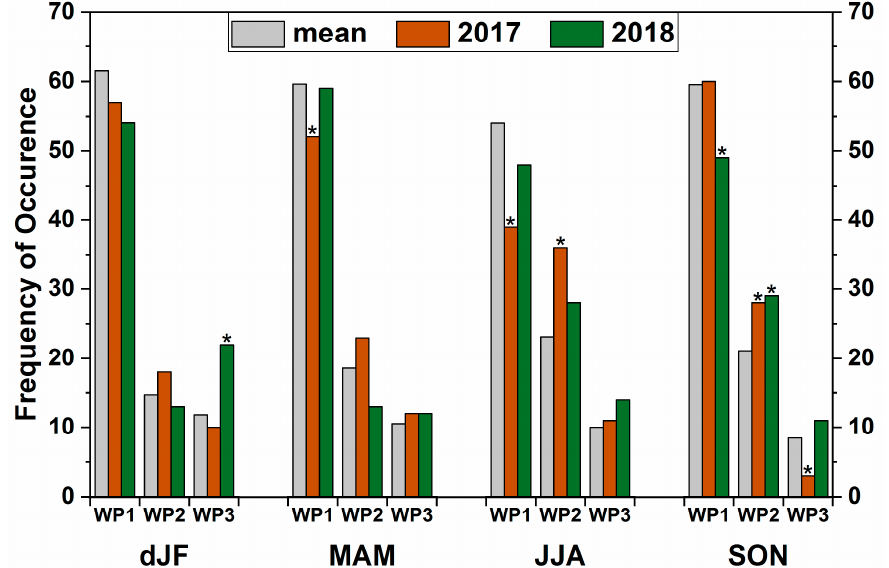
Figure 4. Frequency of occurrence of the different weather patterns on a seasonal basis in 2017 and 2018 compared with the long-term mean (1980–2018). Significant deviations (Student’s t -test, p = 0.05) are marked with an asterisk. The lower-case letter indicates the previous year’s